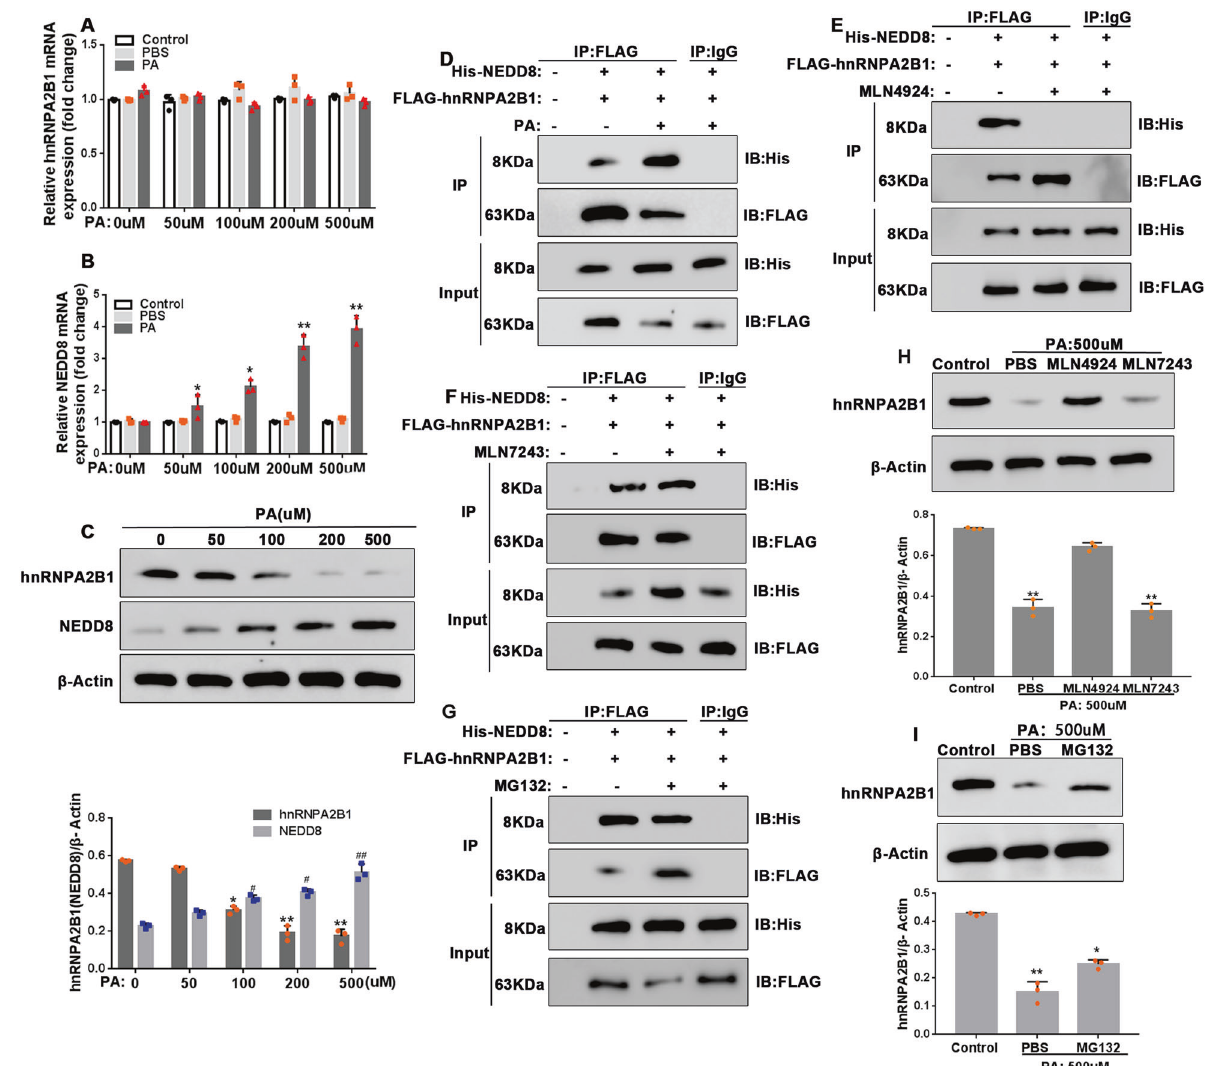
Fig. 3 PA promotes neddylation-mediated hnRNPA2B1 protein degradation. A – C AR42J cells were treated with PA at the indicated concentrations for 12 h. A , B Relative mRNA expression levels of hnRNPA2B1 ( A ) and NEDD8 ( B ) were assessed by qRT-PCR. C hnRNPA2B1 and NEDD8 protein expression levels were examined by western blot analysis. n = 3; * P < 0.05, ** P < 0.01 vs . 0 μ M PA. D – F , H AR42J cells co- transfected with His-NEDD8 and Flag-hnRNPA2B1 were treated with 500 μ M PA for 12 h without ( D ) or with 2 h pre-treatment with 3